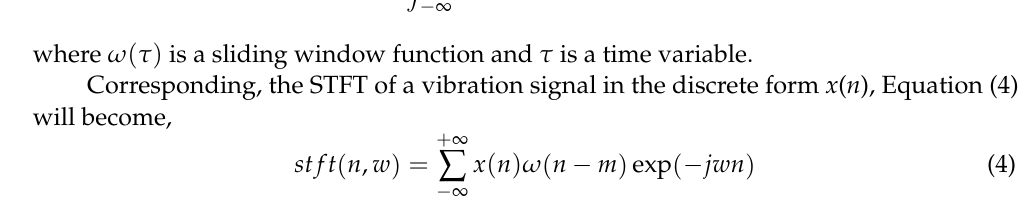
Figure 4. Time, frequency (FT), and time-frequency domain (STFT) signal analysis approach. Short Time Fourier